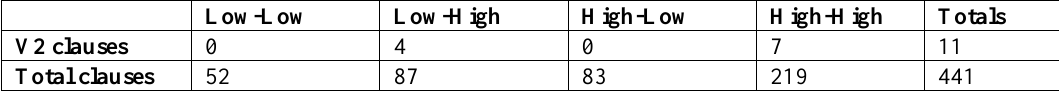
Table 6 . Number of V2 clauses in d’Estouteville